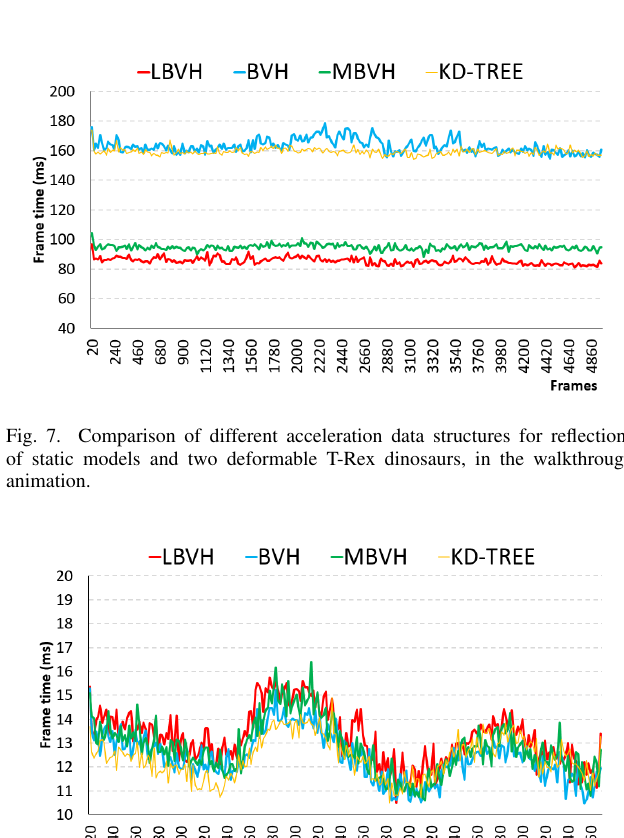
Fig. 6. Animation sequence showing some keyframes of the walkthrough with a camera zoom-in on the reflections produced around one of the deformable T-rex dinosaur.